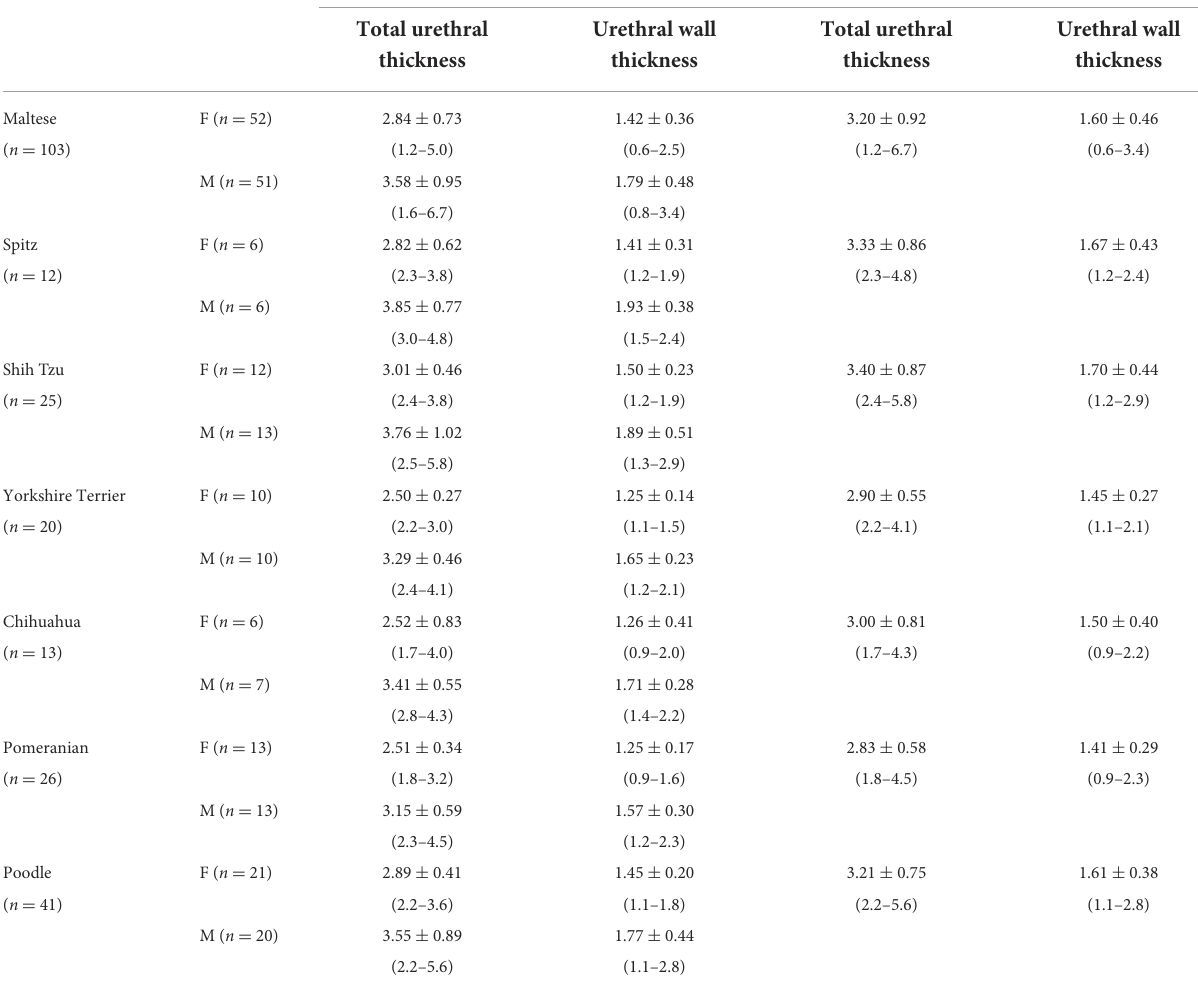
TABLE 2 Values of total urethral thickness and urethral wall thickness in groups divided by breeds and sexes (Maltese, Spitz, Shih Tzu, Yorkshire Terrier, Chihuahua, Pomeranian, and